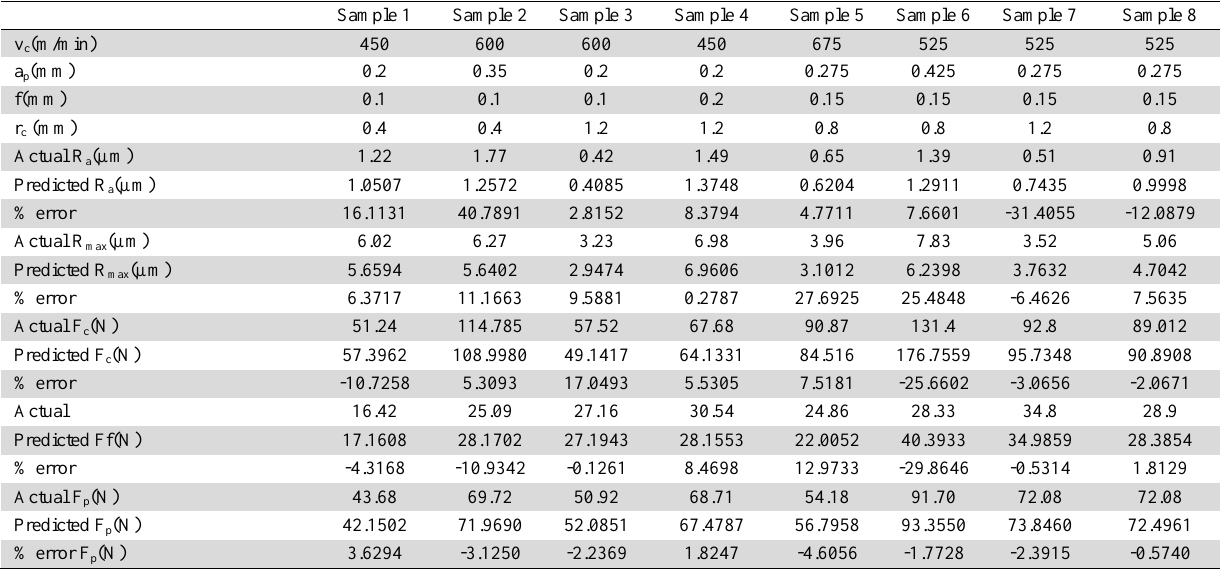
Table 2 Testing the network with eight new